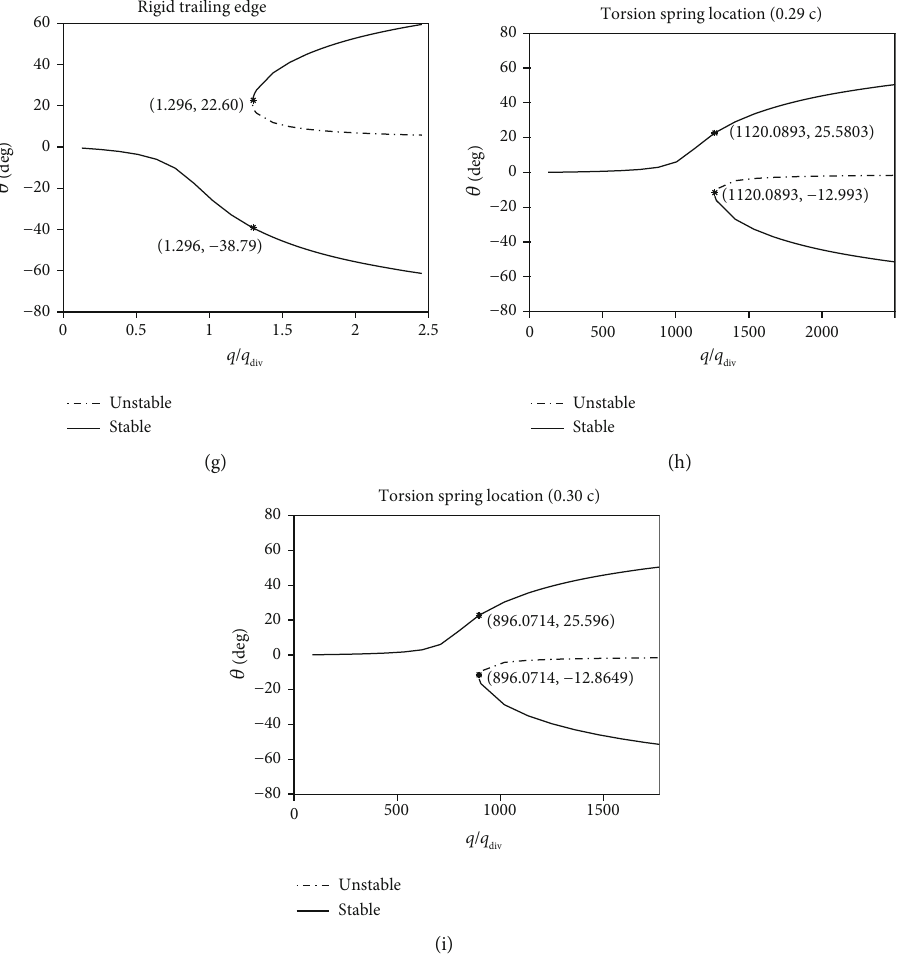
Figure 8: Relationship between dynamic pressure and pitch angle θ in equilibrium state using the geometrically exact